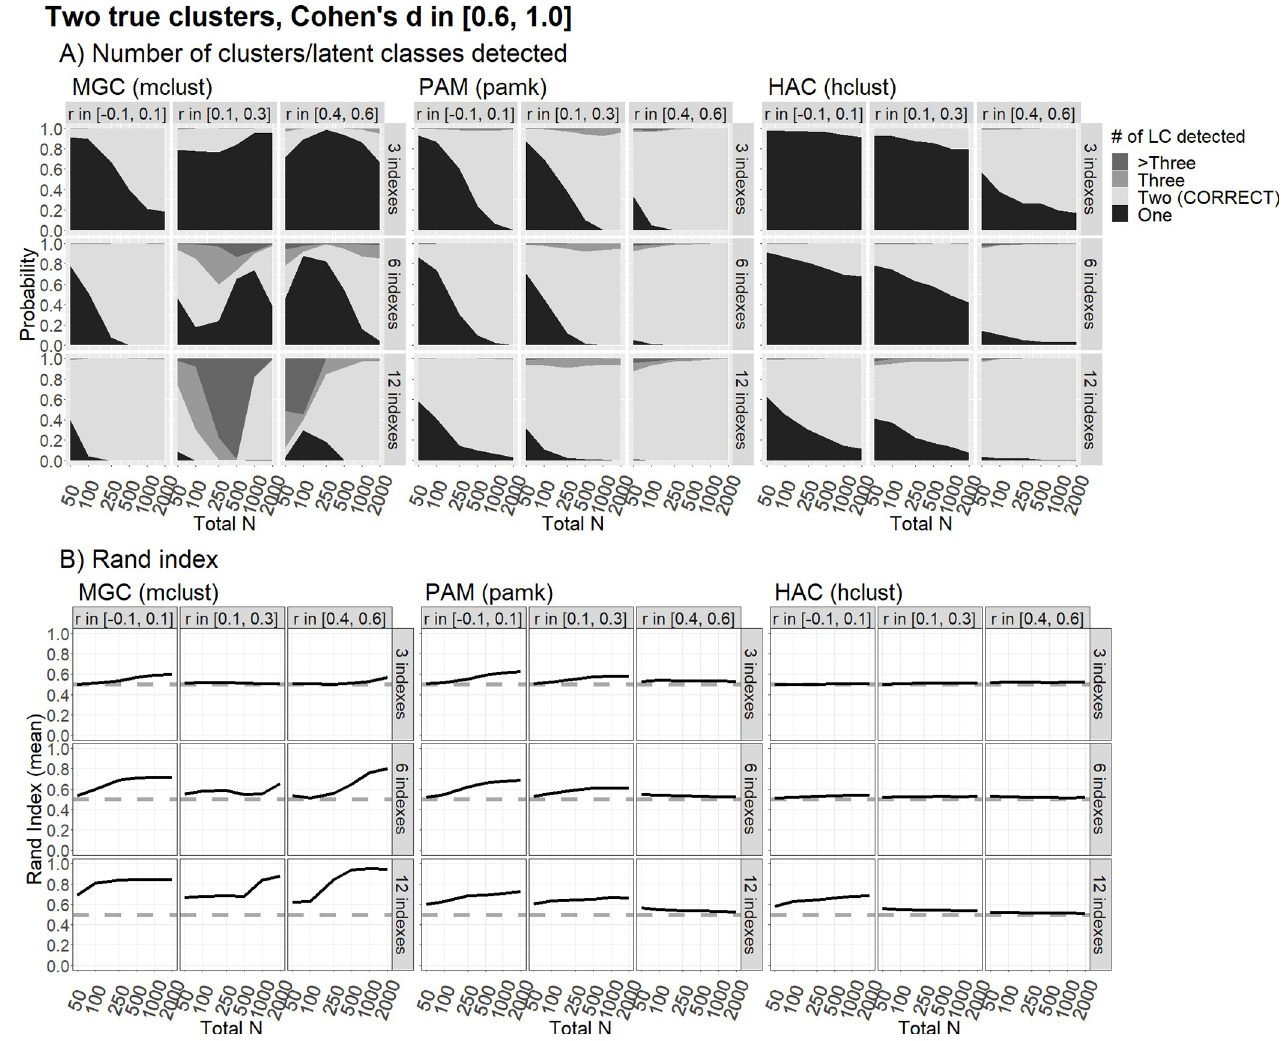
Fig 4. Clustering performance with two true clusters/latent classes and large differences. The figure shows the clustering performance in correctly classifying two true clusters/latent classes differing by a large Cohen’s d [0.6, 1.0] across the indices, using the MGC, PAM and HAC methods, in terms of the probability to detect that there are two latent classes, and the average Rand Index, as a function of sample size (N) and correlItion (r) among indices, over 500 replications. Words in parentheses indicate the R functions